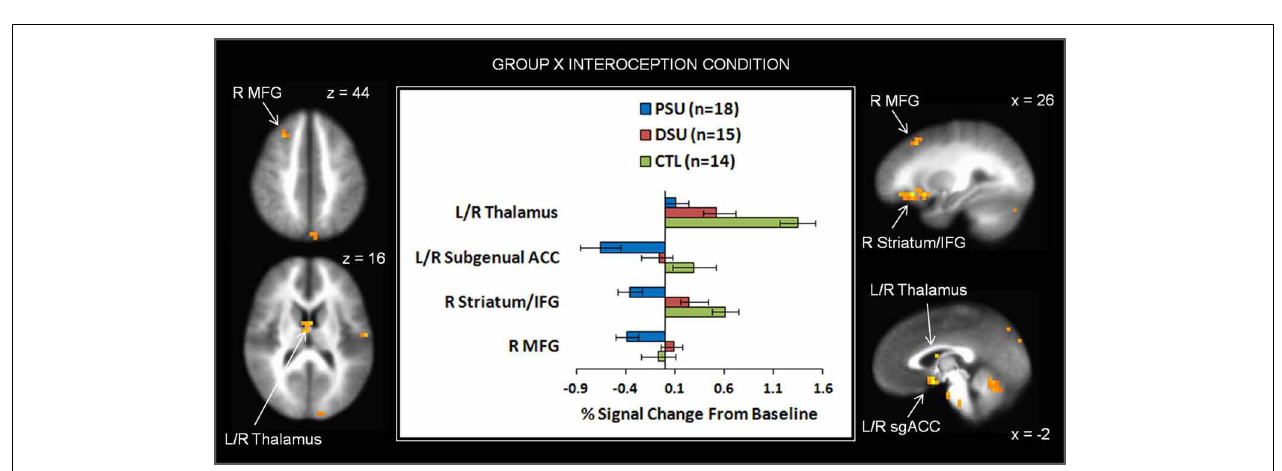
(50% error rate); (2) lower left superior frontal gyrus activation in response to reward (20% error rate); and (3) higher bilateral inferior frontal gyrus (IFG) to punishment. Activation is reflected as percent signal change (%SC) from baseline. Error bars indicate ± 1 standard error.